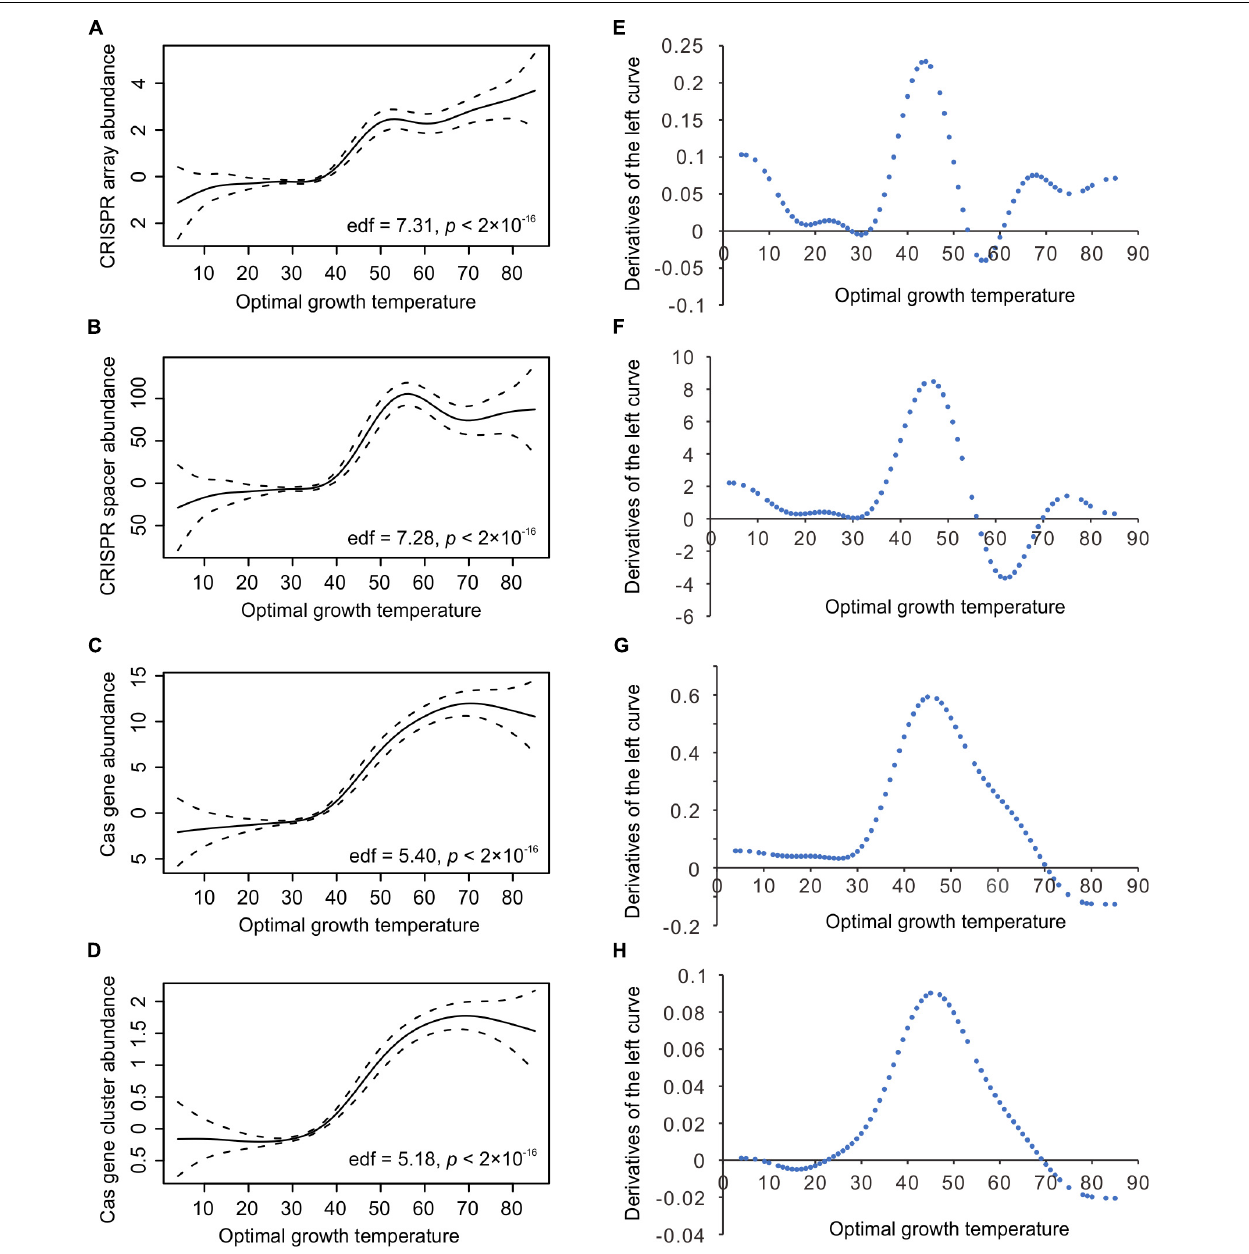
FIGURE 3 | The relationship between bacterial optimal growth temperature (Topt) and the CRISPR-Cas abundance revealed by the generalized additive model (GAM). High non-linearity was detected in the relationship of Topt with CRISPR arrays (A) , CRISPR spacers (B) , cas genes (C) , and cas gene clusters (D) . The derivatives of the GAM curves in (A–D) revealed the most abrupt transitions at 44 ◦ C (E) , 47 ◦ C (F) , 45 ◦ C (G) , and 45 ◦ C (H) , respectively. The effective degrees of freedom (edf) proxy for non-linearity in the